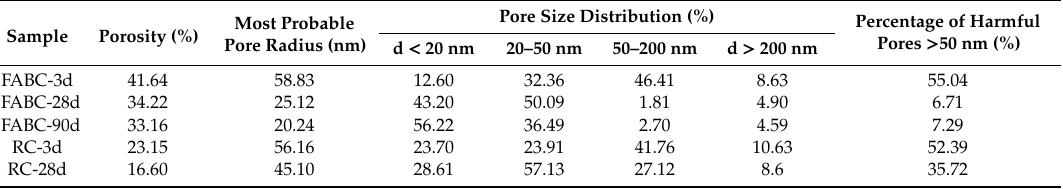
Table 4. Pore structure parameters of di ff erent